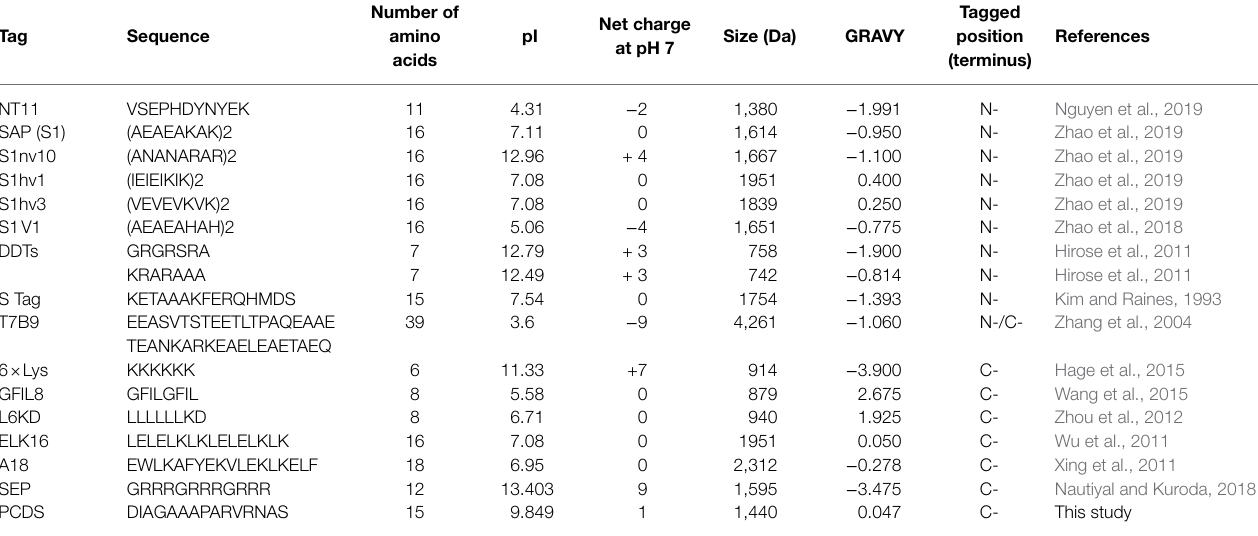
TABLE 3 | Peptide tags to improve heterologous protein expression in Escherichia coli